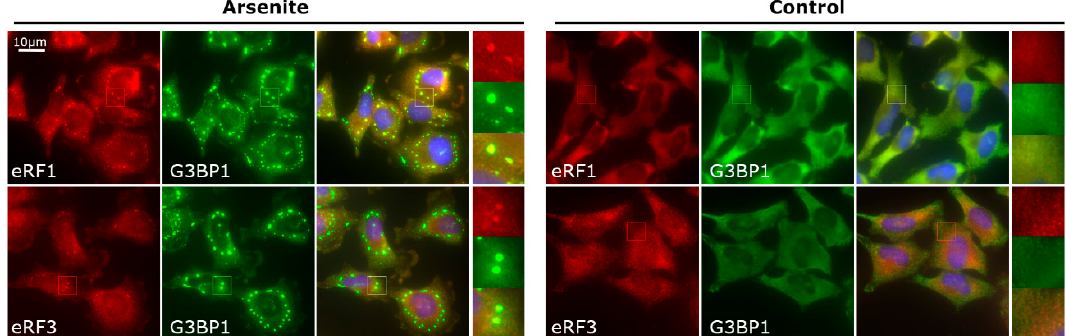
Figure 2. Translation termination factors are recruited to arsenite-induced SGs. HeLa cells were treated with 250 µM sodium arsenite for 1 h (left panel) or left untreated (right panel), followed by fixation and immunostaining for eRF1 or eRF3 (red false color), as indicated, and an SG marker G3BP1 (green channel). A few representative cells are shown; boxes indicate magnified areas. All large images are of the same magnification (scale bar: 10 μ m).